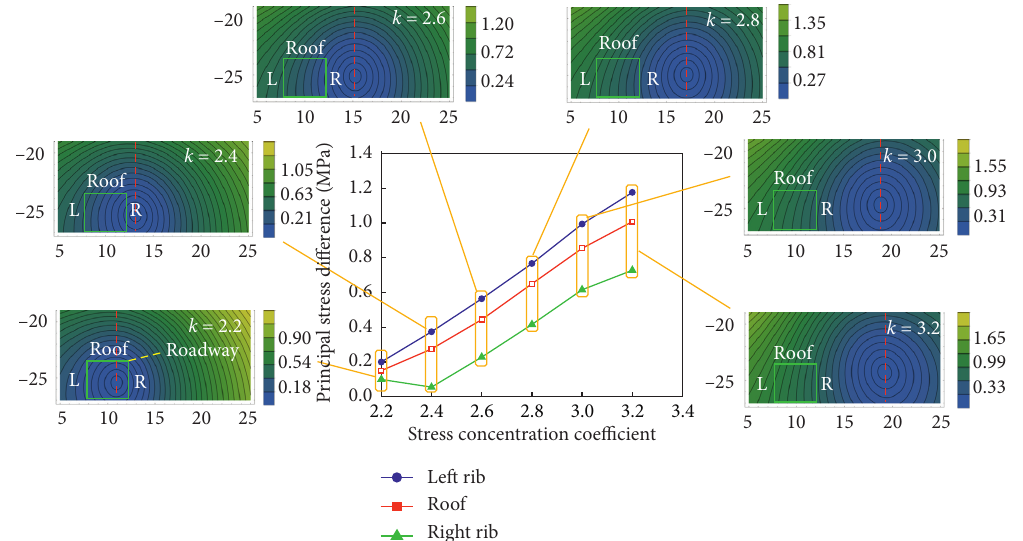
Figure 6: Principal stress differences under different stress concentration coefficients (unit: MPa).